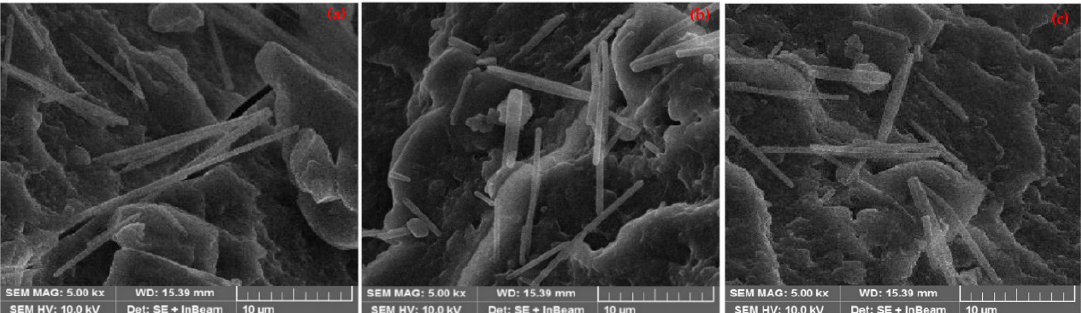
Figure 5. SEM images of AuNRs produced with ( a ) 3 mL of AgNO 3 , ( b ) 4 mL of AgNO 3 , and ( c ) 5 mL of AgNO 3 .